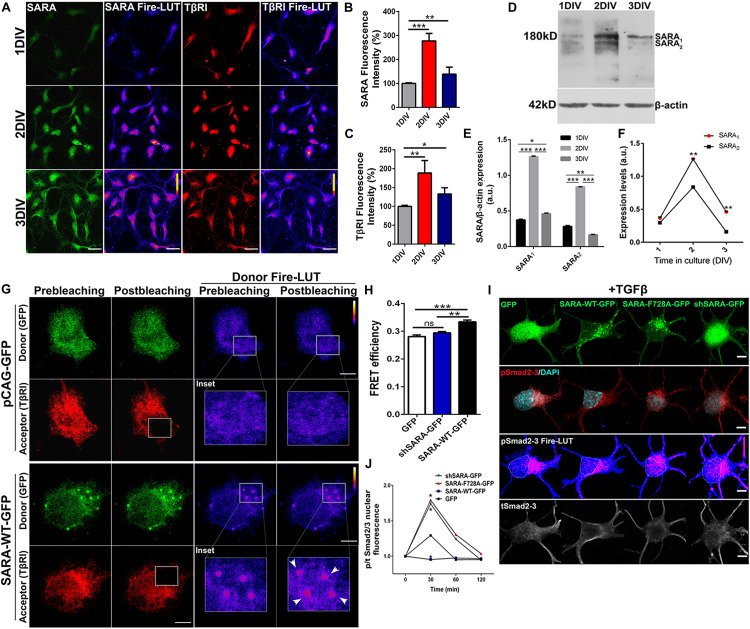
SARA controls TGFβ pathway activation in developing hippocampal neurons. (A) Representative images showing immunofluorescence (IF) detection of endogenous levels of SARA (green), TβRI (red) in cultured hippocampal neurons of 1, 2, and 3 DIV. Fire-LUTs are shown to clearly visualize IF levels. (B,C) Quantification of fluorescence intensity of SARA (B) and TβRI (C). A total of 80 neurons were analyzed for each condition. *p < 0.05, **p < 0.005, ***p < 0.001, ANOVA, Dunnett’s post-test. (D) Representative detection of SARA protein levels by Western blot; protein homogenates were isolated from cultured hippocampal neurons of 1–3 DIV. (E) Western blotting quantification of the SARA1 and SARA2 expression normalized with the load control (β-actin). (F) Representation of the dynamics changes of the expression of SARA1 and SARA2 in cultured hippocampal neurons of 1–3 DIV. (G) Representative images showing transfected neurons with GFP or SARA-WT-GFP (green channel, donor) and immunostained for TβRI (red channel, acceptor: Alexa Fluor 546) for Acceptor Photobleaching (AP)-FRET analysis. Briefly, neurons were transfected after plating and fixed at two DIV for FRET imaging. Squares show the region bleached in the soma (magnification of these regions are shown as insets). Arrows show local interaction between SARA and TβRI at endosomes. (H) Quantification of FRET efficiency in control (GFP) and SARA-WT-GFP neurons at 2 DIV. **p < 0.005, ***p < 0.001 vs control (white column), ns: non-significant, ANOVA, Dunnett’s post-test (15 neurons were analyzed by condition). (I) Representative images of hippocampal neurons transfected with GFP, SARA-WT-GFP, shRNA-SARA, or SARA-F728A-GFP and immunostained to detect phospho-Smad2/3 (red channel), total Smad2/3 (gray channel), and DAPI levels (cyan channel). Neurons were transfected after plating and fixed at 2 DIV for IF staining. (J) Quantification of nuclear phospho/total Smad2/3 IF signal after TGFβ treatment (2 ng/ml) for 0, 30, 60, 120 min in 2 DIV neurons. *p < 0.05 vs control, Kruskal–Wallis test, (20 neurons were analyzed by condition). Results represent the mean of three independent neuronal cultures (n = 3). Scale bar: 20 μm; FRET Scale bar: 5 μm.